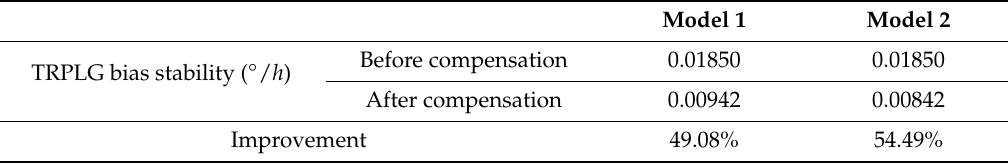
Table 3. TRPLG bias stability for compensated data based on two stepwise regression